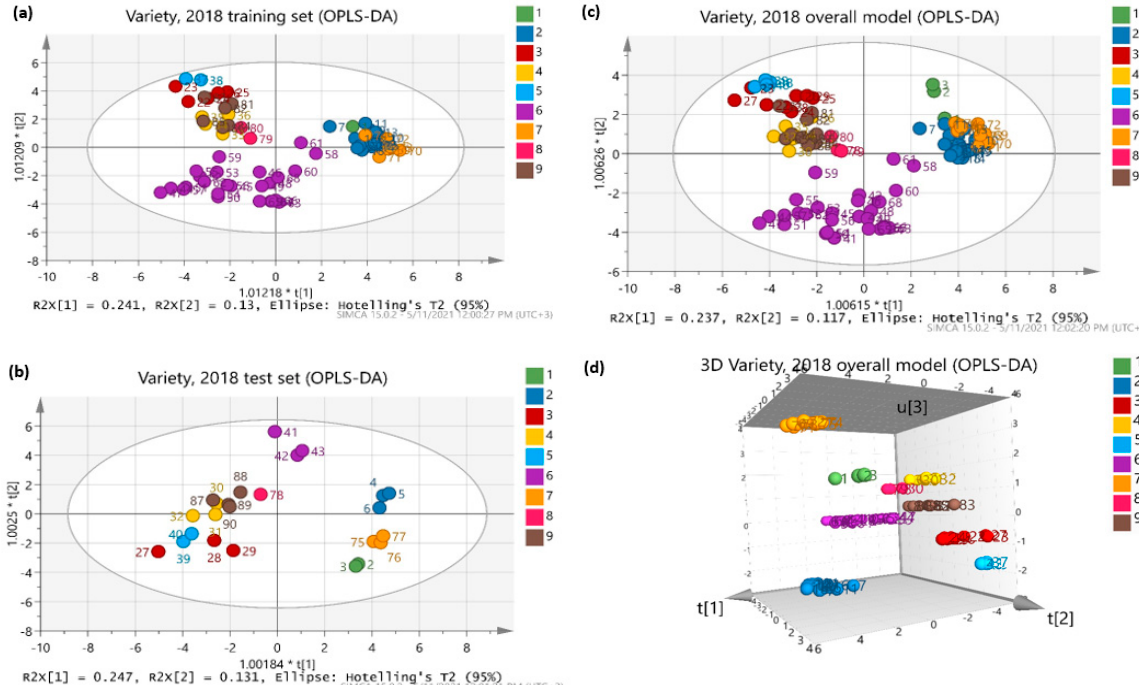
Figure 6. Score scatterplots for the wine samples of 2018 classified regarding variety (i.e., 1: Syrah, 2: Agiorgitiko, 3: Asyrtiko, 4: Malagouzia, 5: Muscat, 6: Moschofilero, 7: Xinomavro, 8: Rodoti, and 9: Savatiano), where ( a ) training set, ( b ) test set, ( c ) overall model 2D, and ( d ) overall model (3D).